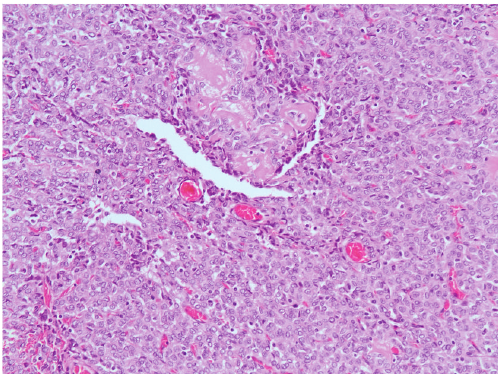
Figure 1: Brain primary tumor.